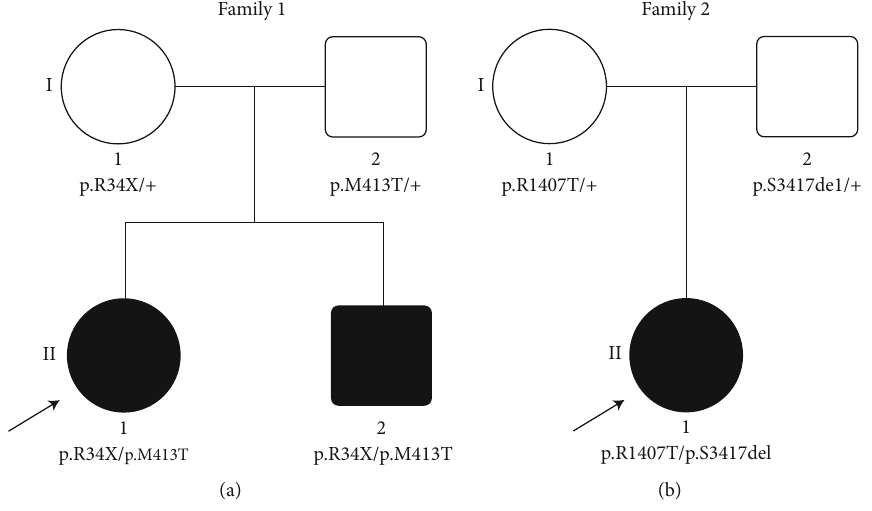
Figure 1: Pedigrees and genotypes of Family 1 (a) and Family 2